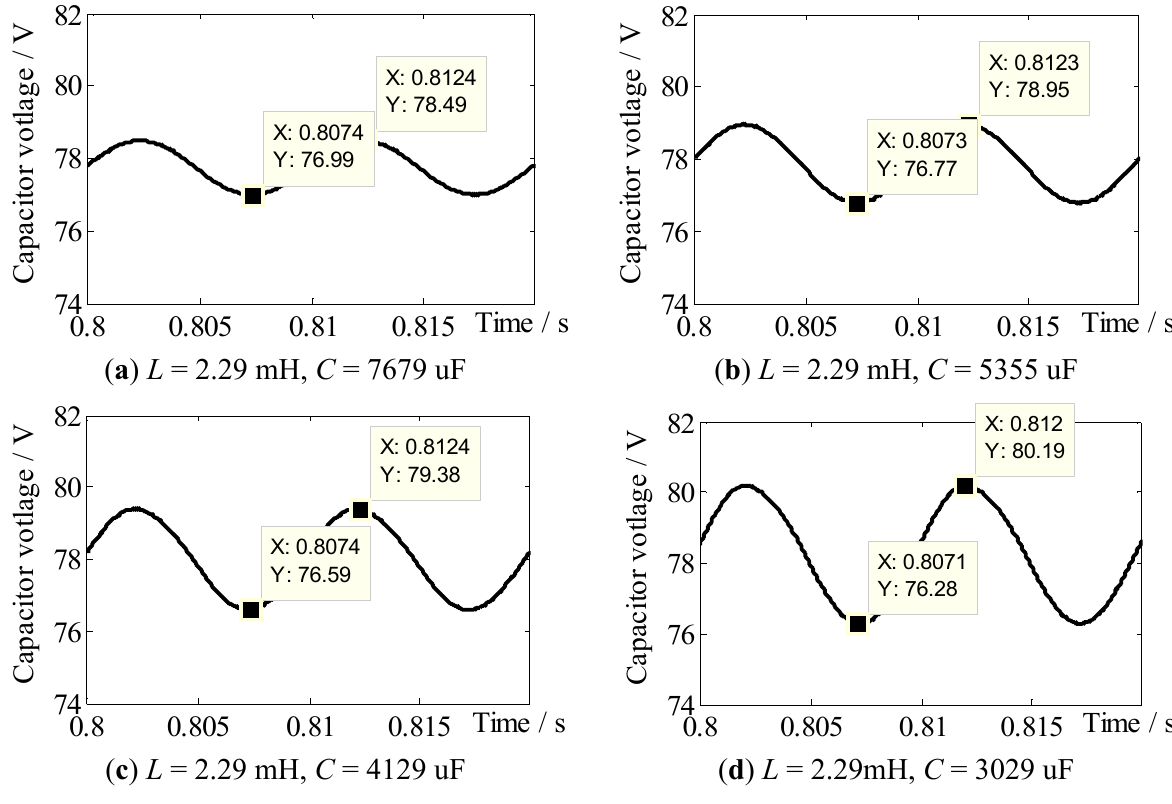
Figure 7. Simulation waveforms of capacitor